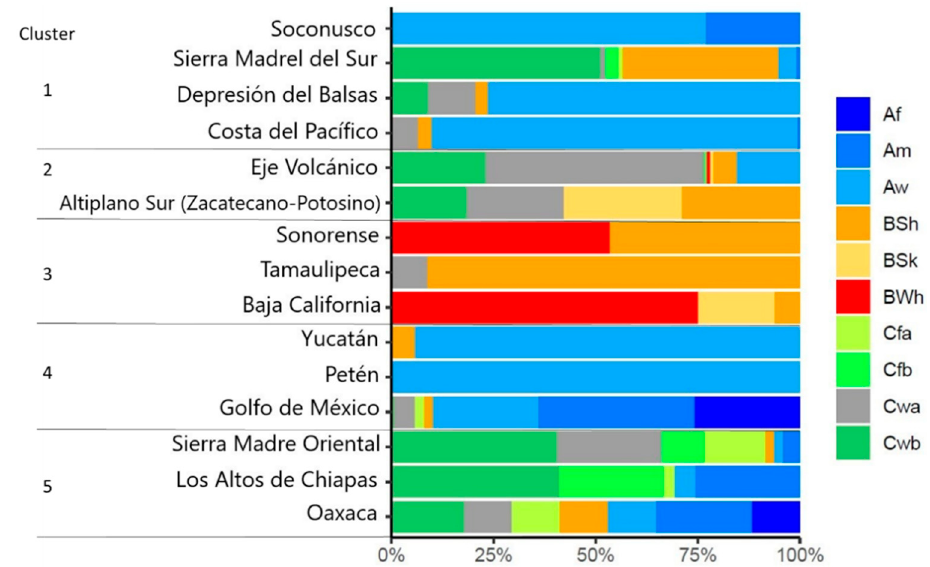
Figure 4. Climatic diversity and climate type percentages for tomato accessions in Mexico by physiographic province according to the groups formed by CA. Climate types according to Beck et al. [29]. Af (Tropical, rainforest), Am (Tropical, monsoon), Aw (Tropical, Savannah), BWh (Arid, desert, hot), BSh (Arid, steppe, hot), BSk (Arid, steppe, cold), Cwa (Temperate, dry winter, and hot summer), Cwb (Temperate, dry winter, and warm summer), Cfa (Temperate, no dry season, and hot summer), and Cfb (Temperate, not dry season, warm summer).